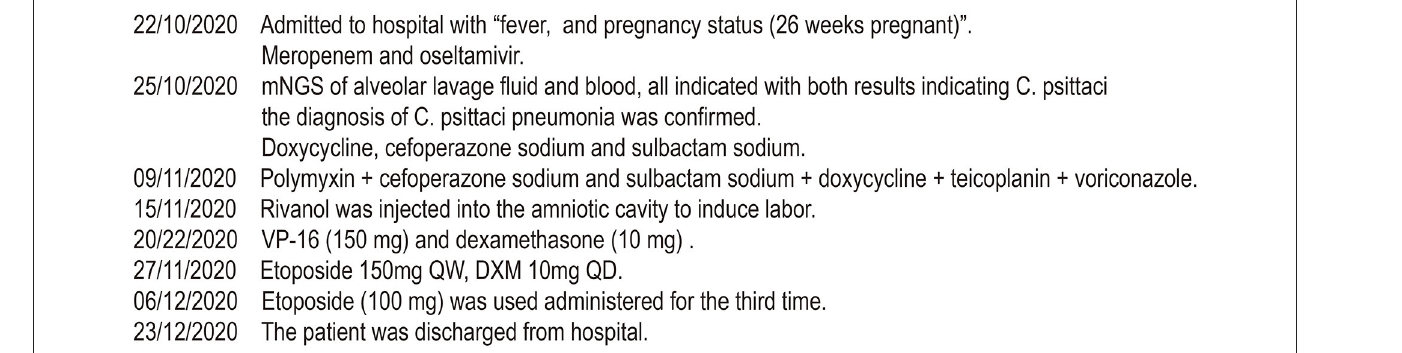
FIGURE 3 | Timetable used to show the progress of the disease and the patient’s